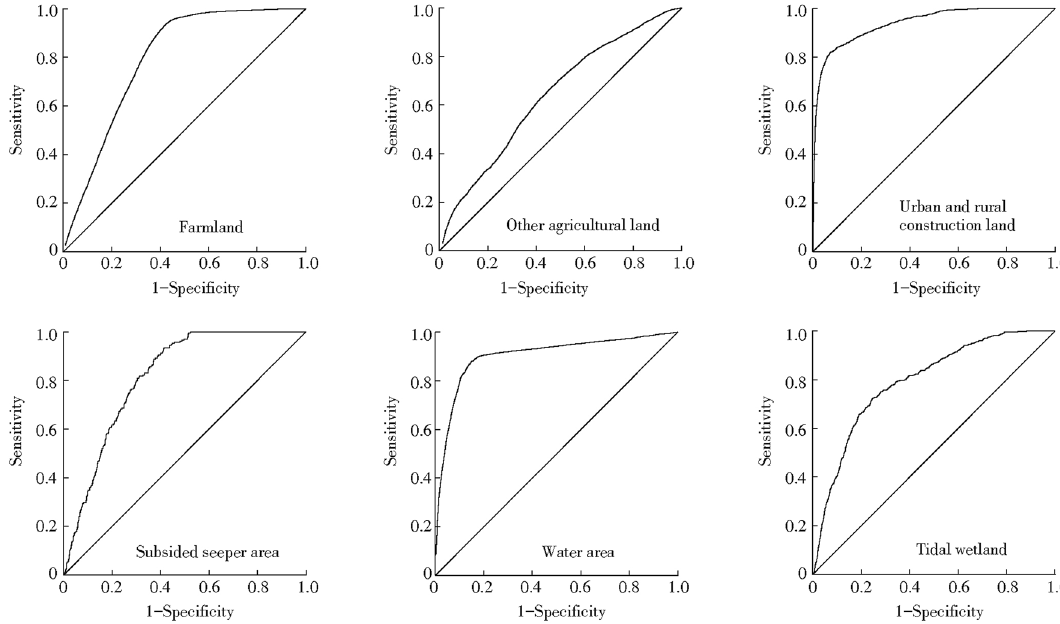
Figure 4. ROC curves for regression analysis of LULC type and driver factors.